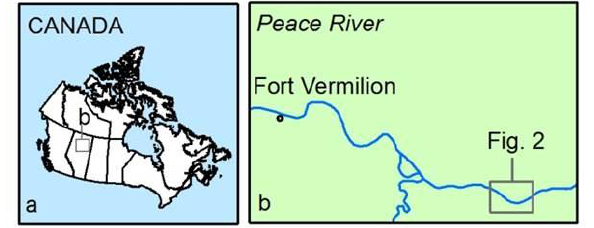
Figure 1. Location of the study area within (a) Canada and (b) northern Alberta